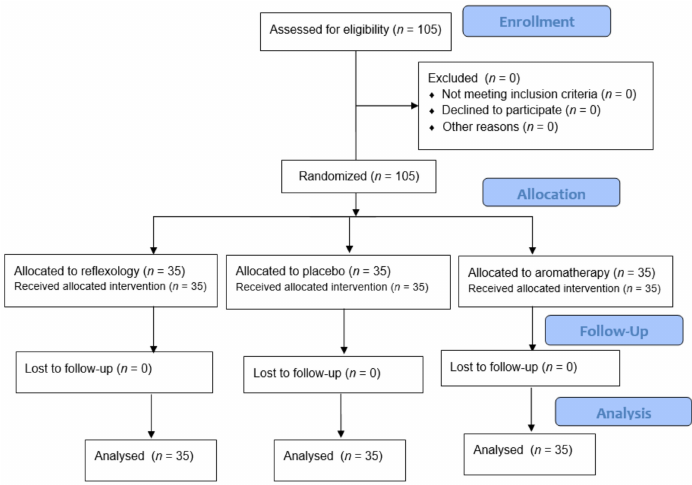
Figure 1. The research process according to the Consolidated Standards of Reporting Trials (CON- SORT) flow